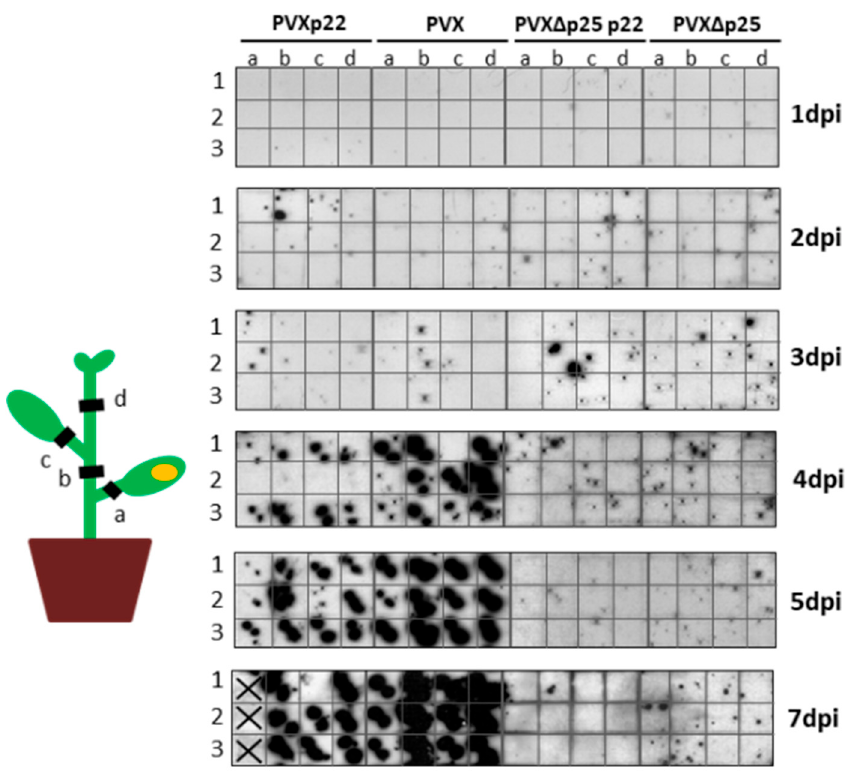
Figure 5. Analysis of the viral systemic spread in Nicotiana benthamiana plants inoculated with Potato virus X (PVX) expressing Tomato chlorosis virus p22 (PVXp22), PVX, PVX ∆ P25p22, and PVX ∆ P25.